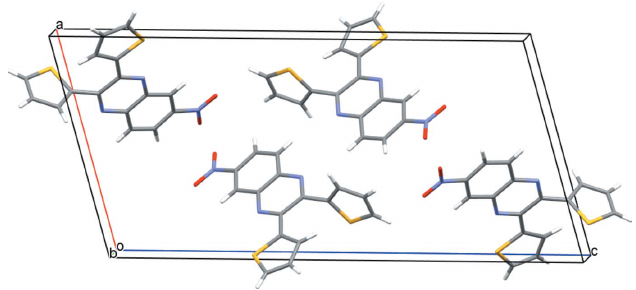
Figure 2 A view of the unit cell of 6-nitro-2,3-bis(thiophen-2-yl)quinoxaline along (010).